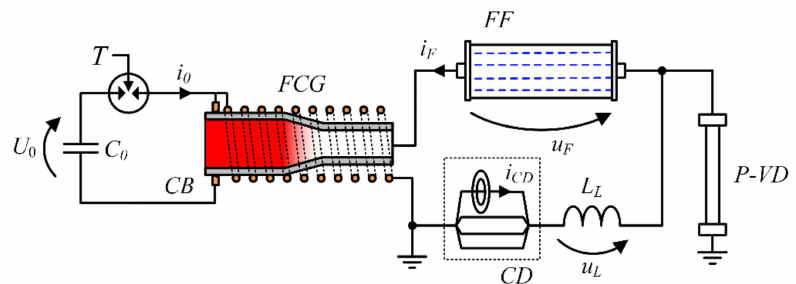
Figure 14. Schematic diagram of an integrated and compact pulse generation and forming system with a FF in cooperation with FCG: C 0 —capacitor bank charged to the initial voltage U 0 , T —trigatron, L L —inductance of the pulse forming coil, P-VD— pulse high voltage divider, CD —current divider, i 0 —FCG excitation current, i F — fuse current, u F —fuse voltage, u L —forming coil